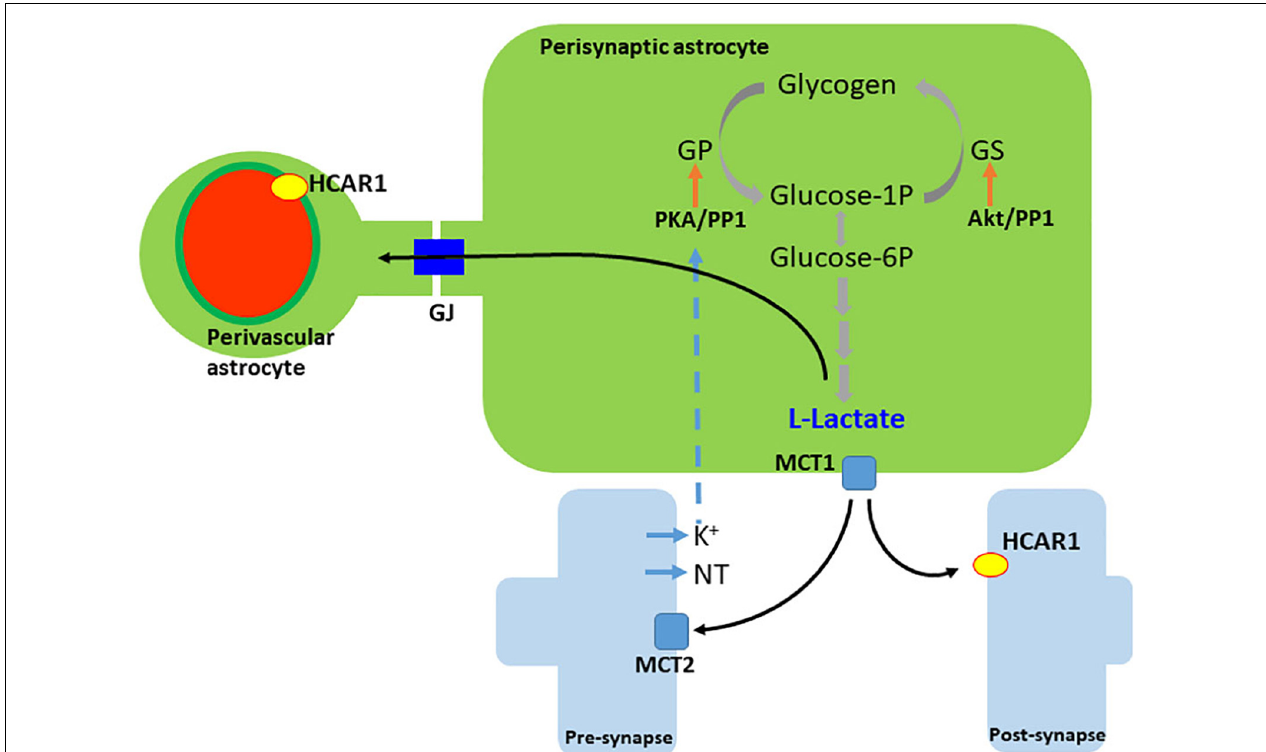
FIGURE 2 | Generation and release of lactate in astrocytes. L -lactate is generated either from recently uptaken glucose or from glycogen. Neurotransmitters (NT), and/or extracellular K + , trigger glycogen breakdown until lactate, via cAMP/PKA signaling. Lactate leaves the cell by the monocarboxylate transporter 1 (MCT1) and enters neurons via the monocarboxylate transporter 2 (MCT2). Extracellular lactate also binds to hydroxy-carboxylic acid receptor 1 (HCAR1), which is found more abundantly in perivascular and post-synaptic membranes. Lactate travels among astrocytes through gap junctions (GJ). PKA, protein kinase A; GP, glycogen phosphorylase; GS, glycogen synthase; PP1, protein phosphatase 1.